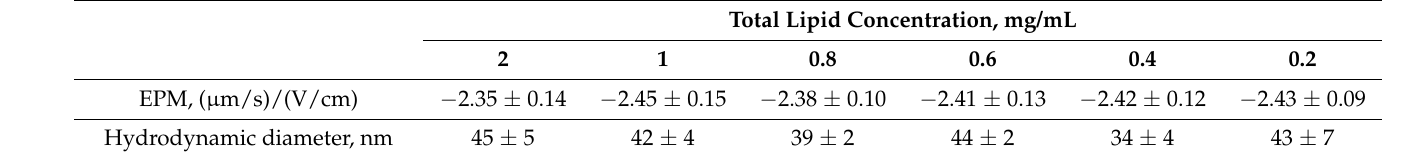
Table 1. EPMs and particle sizes (hydrodynamic diameter) of anionic CL/Chol/DOPC liposomes of different concentrations.